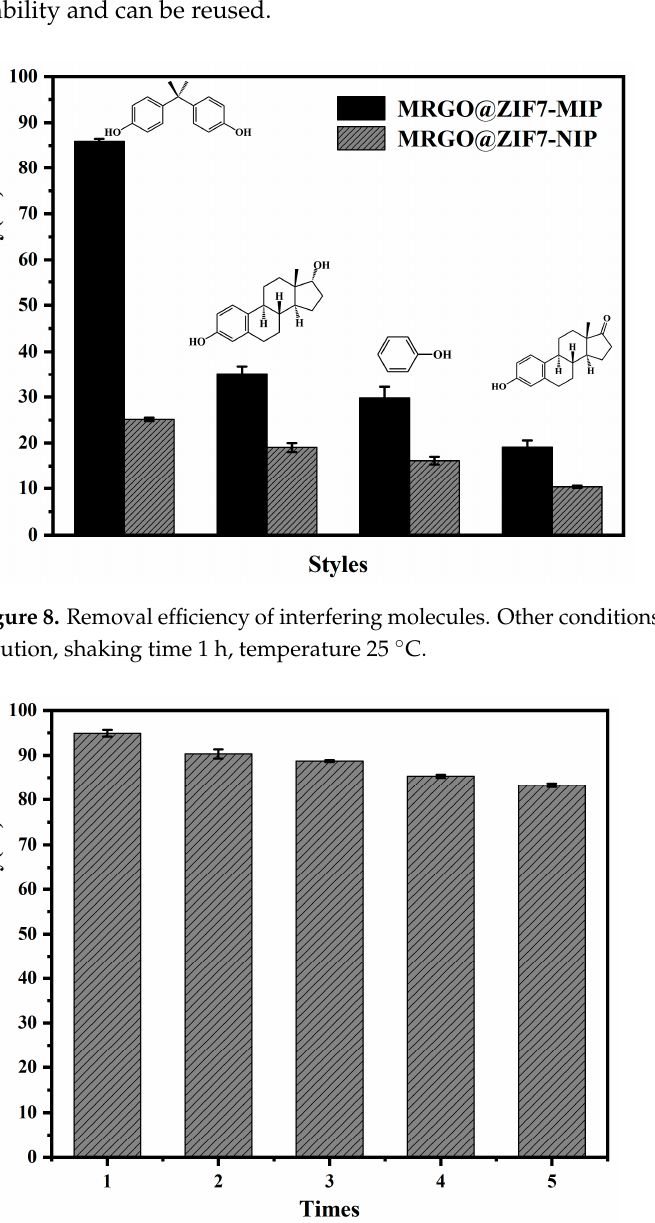
Figure 9. Stability and repeatability of the MRGO@ZIF7-MIP. Other conditions: 10 mg sorbent, 10 mL sample solution of 0.08 mmol L-1 BPA, temperature 25 °C.